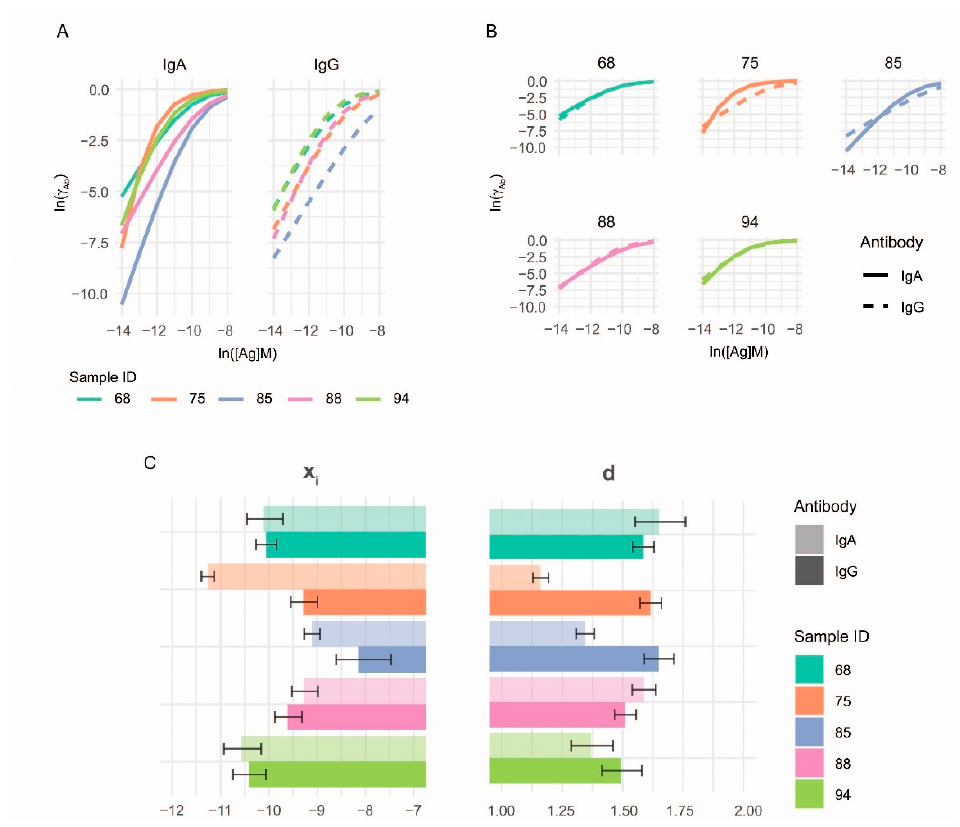
Figure 3. Comparative characterization of serum antibody binding. Using the values of the parameters obtained by curve fitting, calculated thermodynamic activity coefficient distributions are comparable not only for ( A ) serum samples but also for ( B ) distinct antibody classes. Results shown in Figure 2 were used for the generation of normalized comparisons. Bar charts ( C ) show mean d and x i values, and 95% confidence intervals as whiskers.